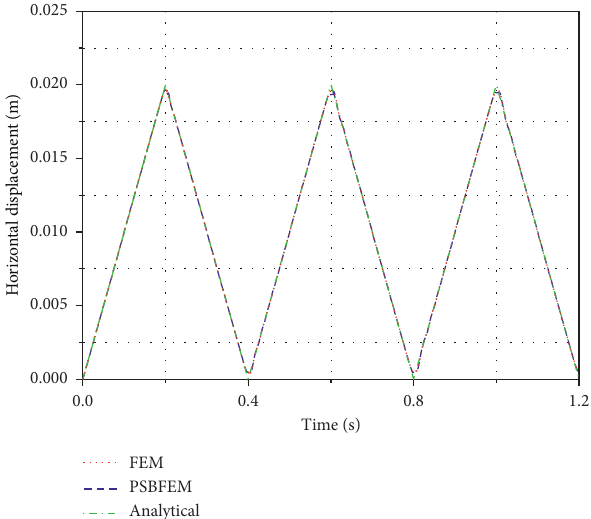
Figure 12: Time history of the horizontal displacement of the monitoring point.